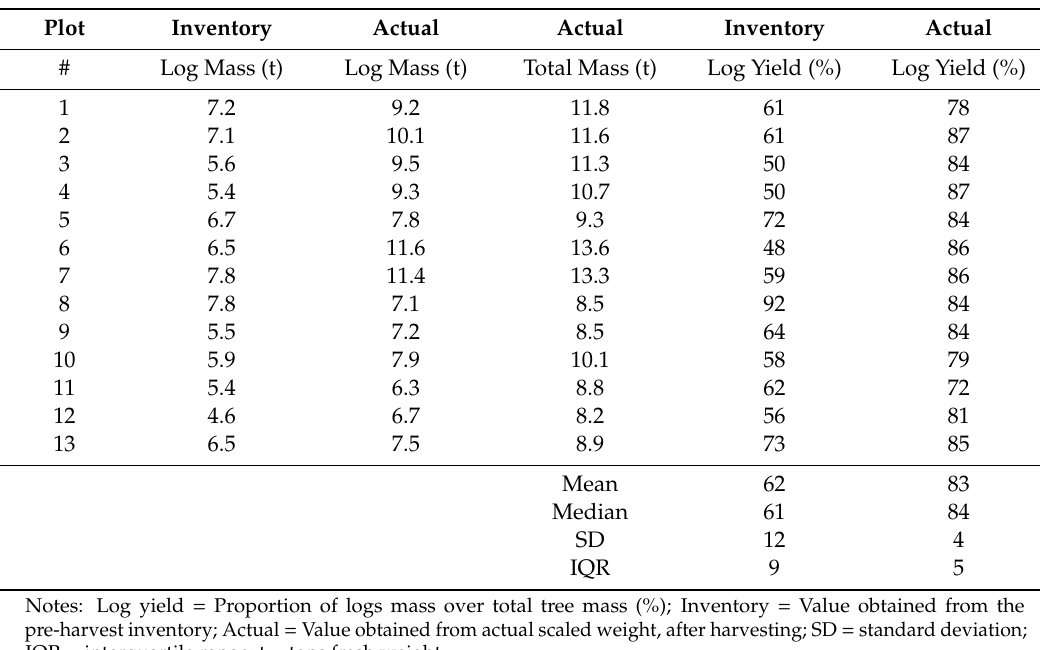
Table 4. Theoretical and actual log yield.